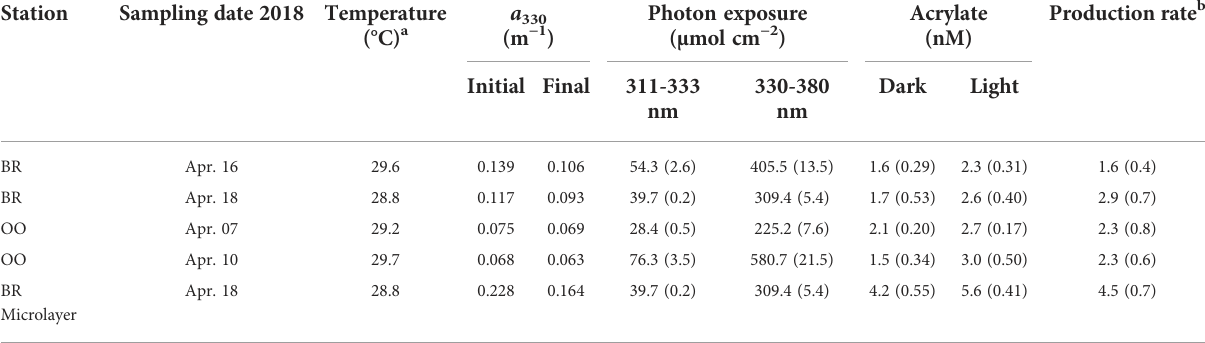
TABLE 3 Acrylate concentration in dark controls (dark, n = 4) and light-exposed quartz tubes (light, n = 4), the temperature for each photochemical experiment (T), initial and fi nal CDOM absorption coef fi cient at 330 nm ( a 330 ), and the photon exposure between 311 – 333 nm and 330 – 380 nm determined using nitrate and nitrite actinometry,